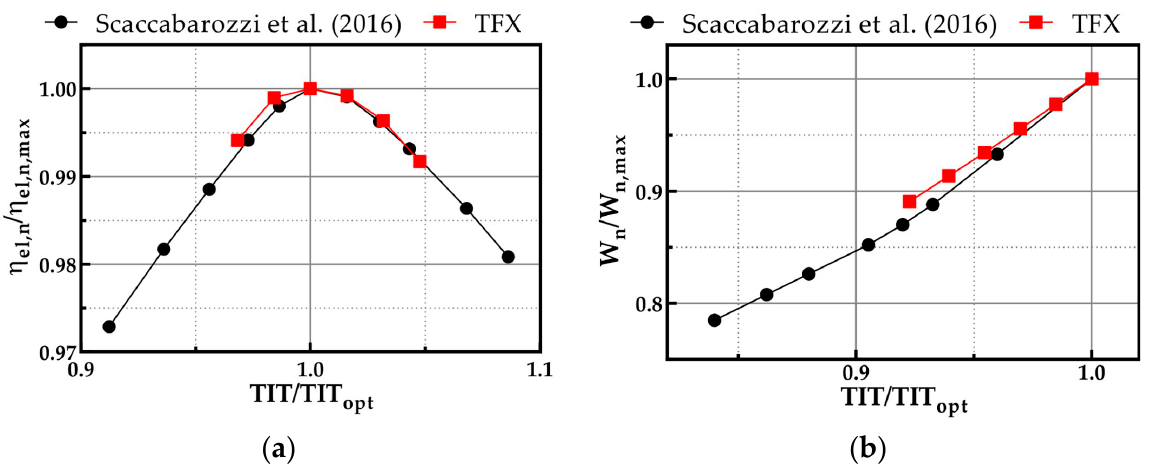
Figure 5. Allam cycle performance as a function of turbine inlet temperature: ( a ) net electric efficiency; ( b ) net specific work. Validation against Scaccabarozzi et al., thermodynamic analysis, and numerical optimization of the NET Power oxy-combustion cycle [26].